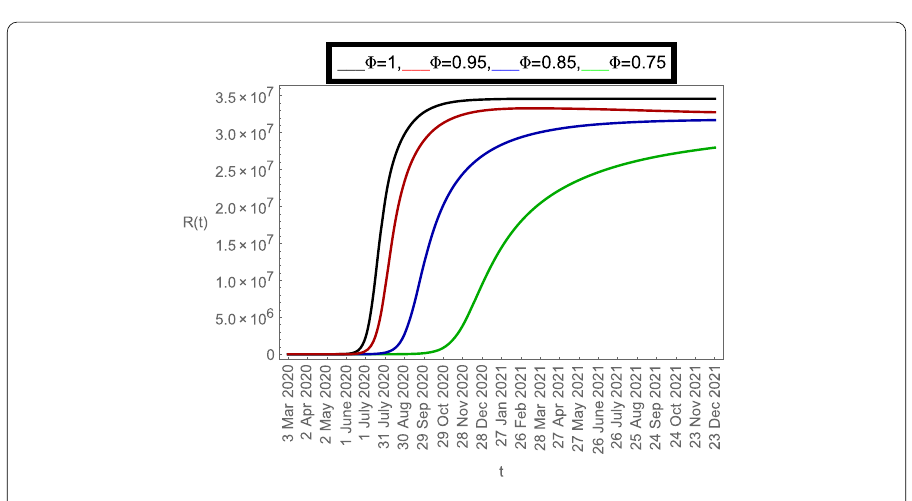
Figure 12 Dynamics of R ( t )